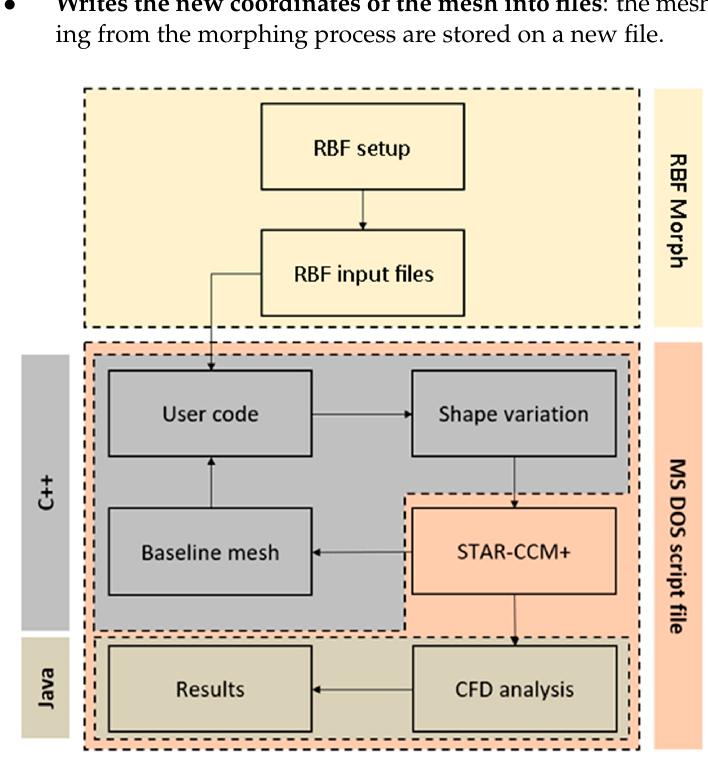
Figure 2. Flowchart of the automated analysis workflow.